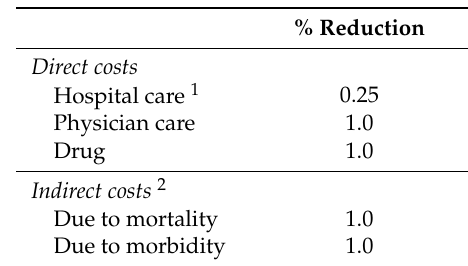
Table 4. Estimations of percent cost reduction corresponding to each 1% decrease in incidence of each of type 2 diabetes and cardiovascular